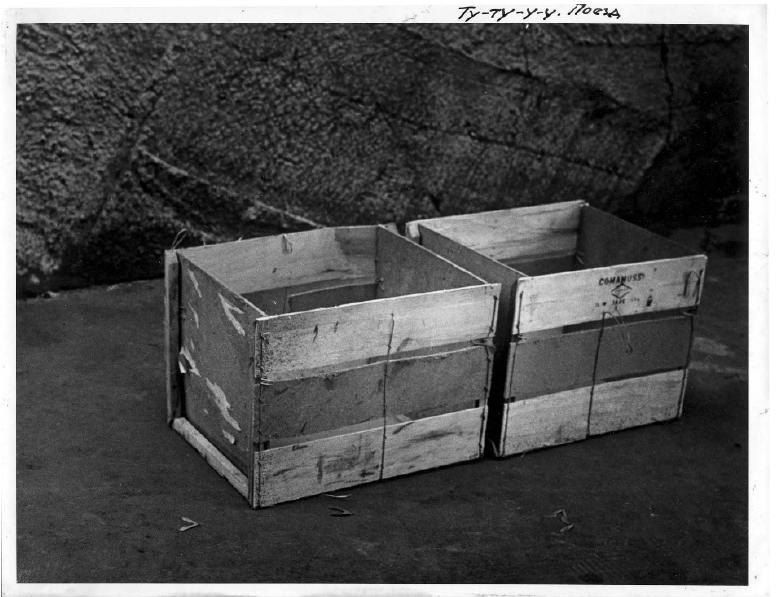
Figure 9. Skersis. Choo-choo train . 1979. Wood, metal, black-and-white photograph. Courtesy of the artist.